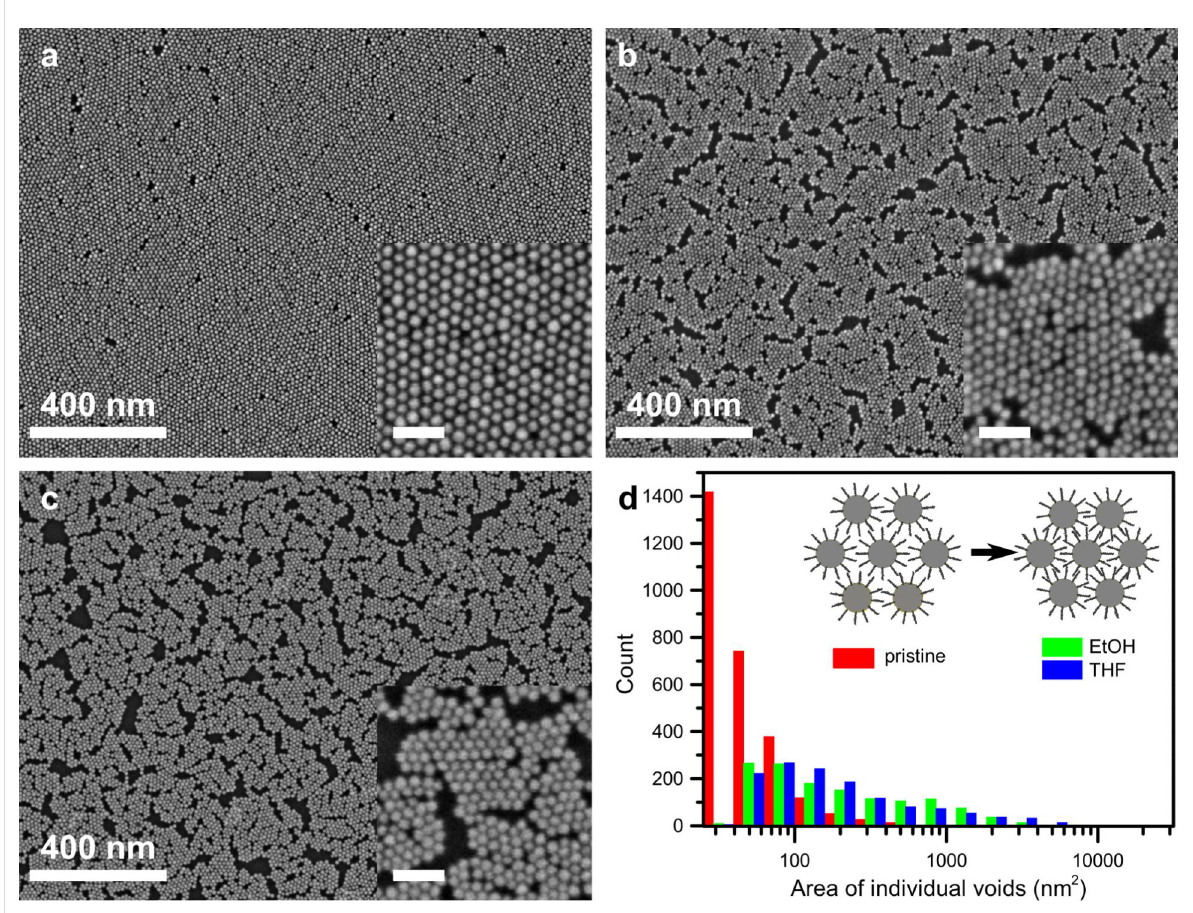
Figure 2: SEM images of (a) a pristine gold nanoparticle monolayer, (b) after EtOH immersion and (c) after THF immersion. Scale bar inset is 50 nm. (d) Histograms of the area of individual voids of the SEM images shown in (a)–(c) and a schematic illustration of solvent-induced compaction leading to void formation.